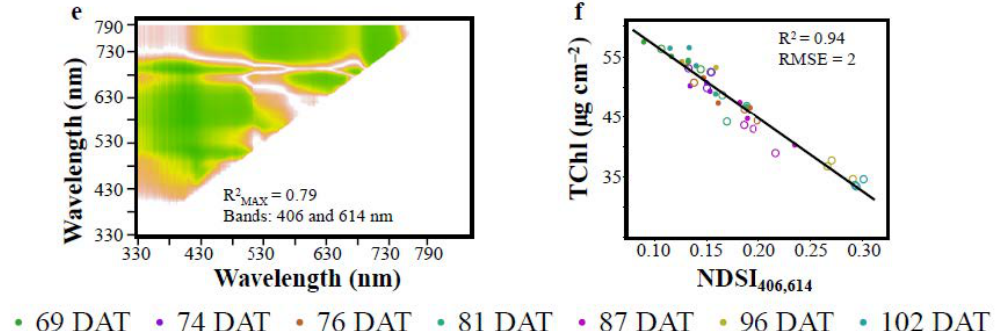
Figure 3. All possible two-band combinations by normalized difference vegetation index (NDSI) heat maps R 2 values ( p < 0.0001) for regression with Chl-a, Chl-b, and TChl content on all 168 samples ( a , c , e ). Linear regression of Chl-a, Chl-b, and TChl ( n = 42) with their corresponding highest-ranking NDSI based on averaged NDSI values per genotype, irrigation regime and DAT ( b , d , f ). The black lines are the trend line. Chl-a ( a , b ), Chl-b ( c , d ), and TChl ( e , f ). Hollow and filled dots stand for water-limited (WL) and well-watered (WW), respectively. RMSE stands for root mean square error; DAT stands for days after transplant.